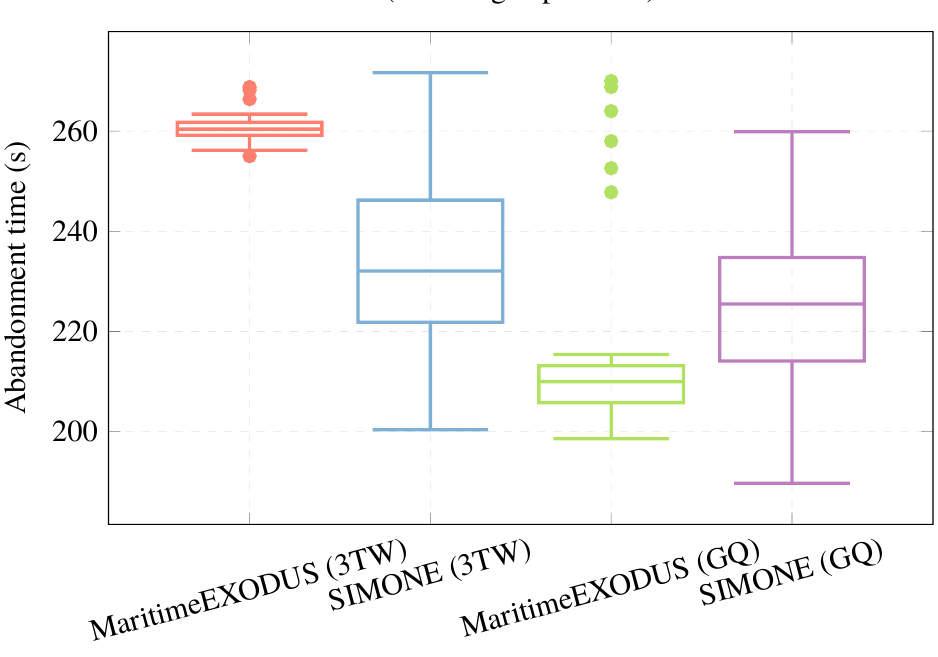
Figure 4. Box plots, abandonment times (MaritimeEXODUS vs. SIMONE) for the starting situations GQ and 3 TW in an undamaged